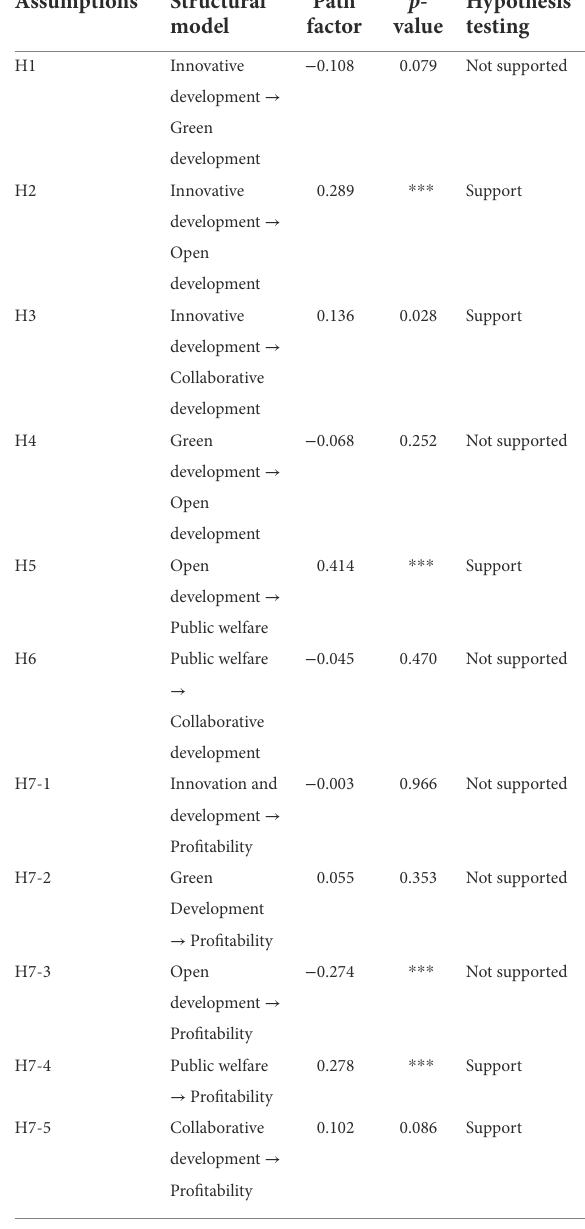
TABLE 5 Hypothesis testing